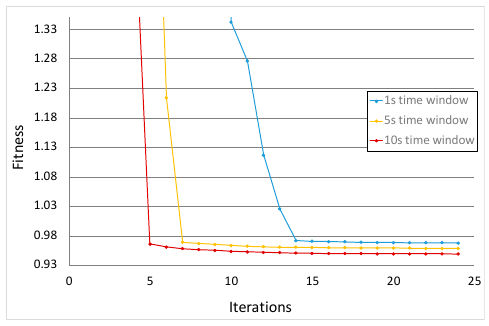
Figure 11. Evolution of the mean value of the fitness of the best solution found by the DE algorithm in the feasible region for the case of two intermediate timing point.